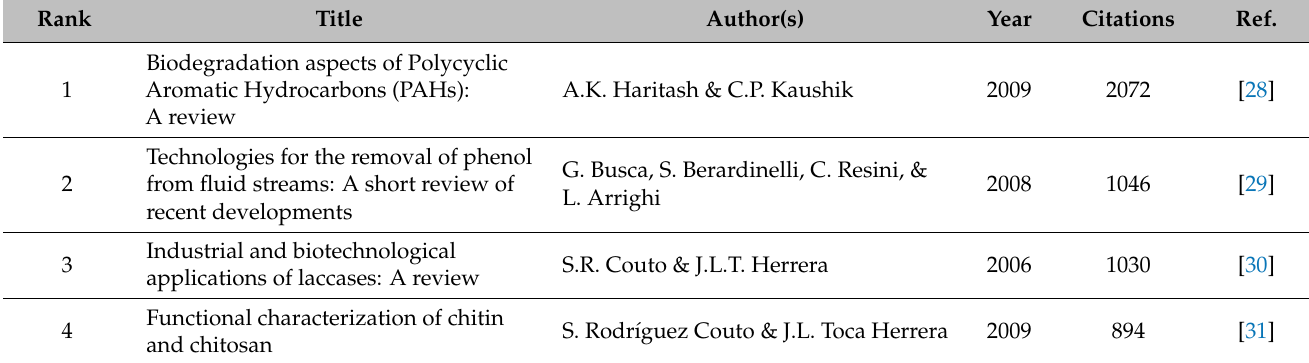
Table 6. Top 10 most cited papers reporting on laccase-assisted wastewater